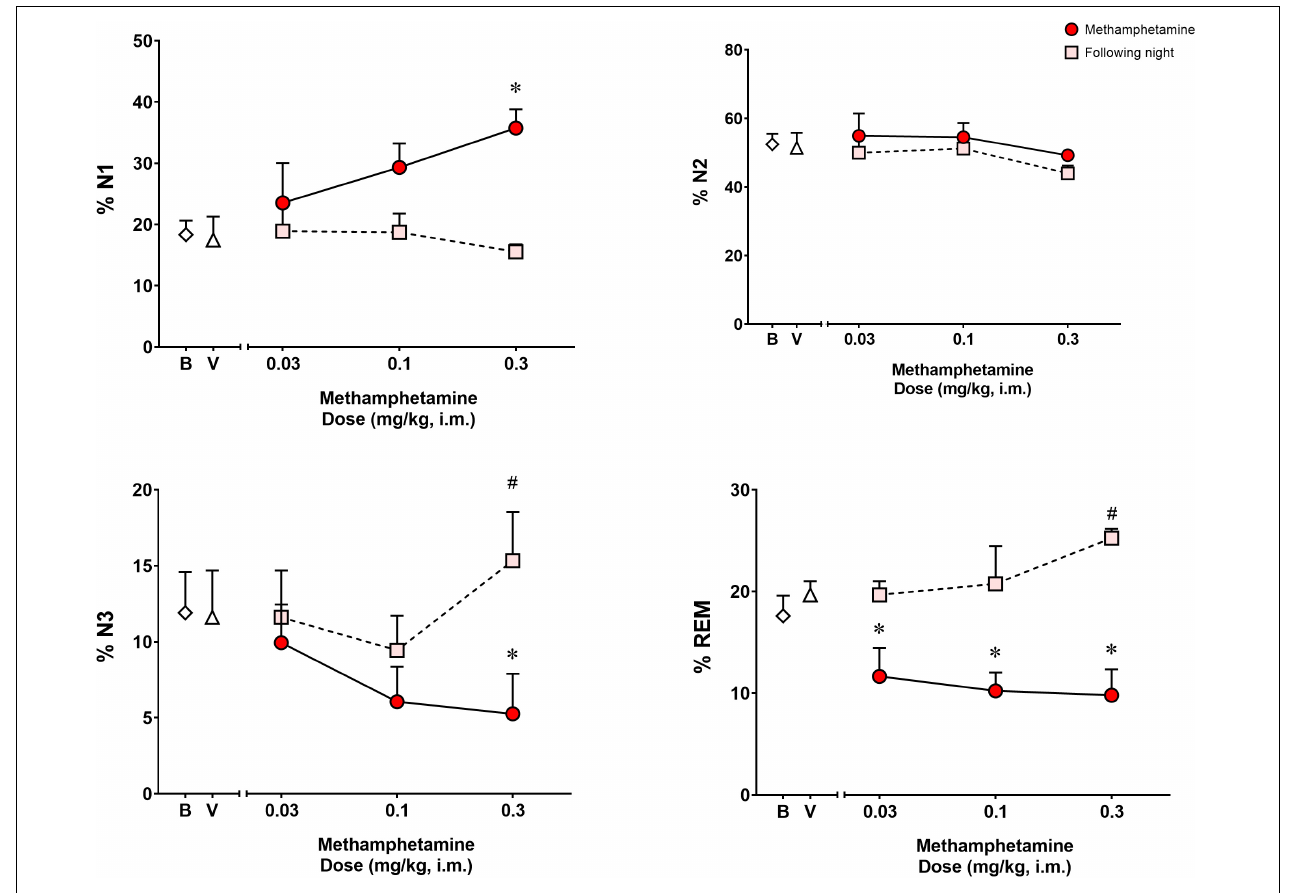
FIGURE 3 | Percentage (%) of total sleep time spent in sleep stages N1, N2, N3, and REM on the night of methamphetamine treatments and during the following night (second night after methamphetamine treatments) in male rhesus monkeys ( N = 4). Sleep data on nights of methamphetamine treatment were compared to sleep data on nights of vehicle (V) treatment. “Following night” sleep data (rebound effects) were compared to baseline (B) sleep data. Data are expressed as mean ± SEM. ∗ p < 0.05 compared to vehicle (V); # p < 0.05 compared to baseline